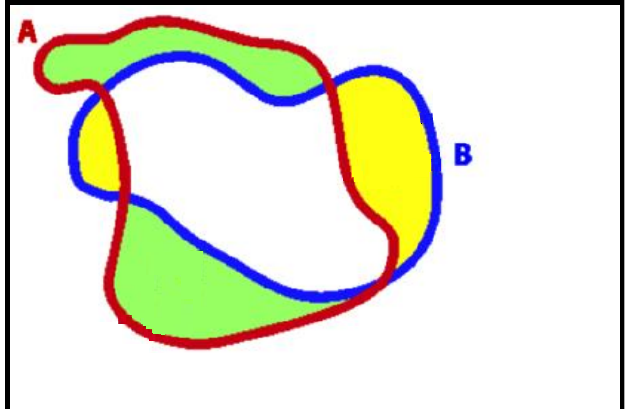
Figure 15. The region-based error between the algorithm’s boundary (A) and the ground truth boundary (B).